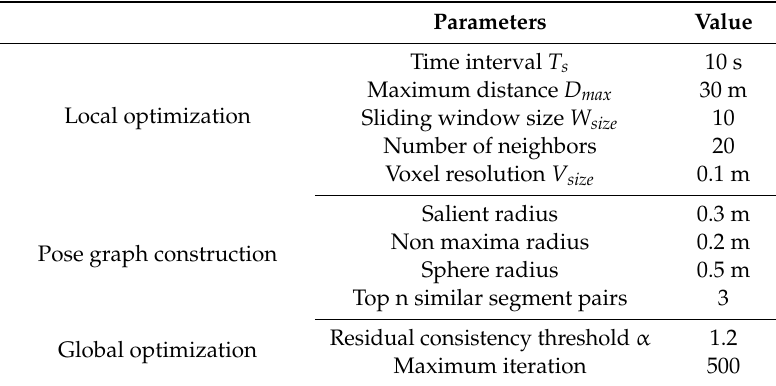
Table 2. Overview of the parameters applied in